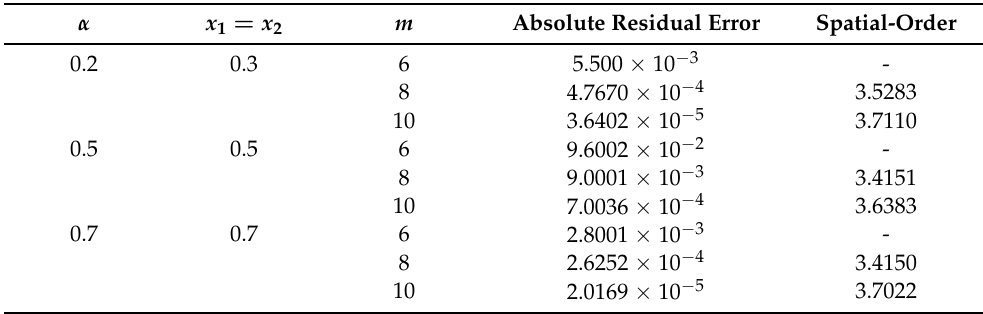
Table 5. The absolute residual error and average convergence order in spatial dimensions for Example Section 2.1 with t = 0.5.